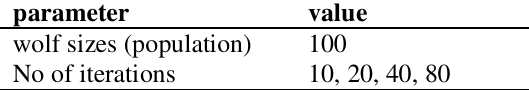
Parameters used for the GWO algorithm.